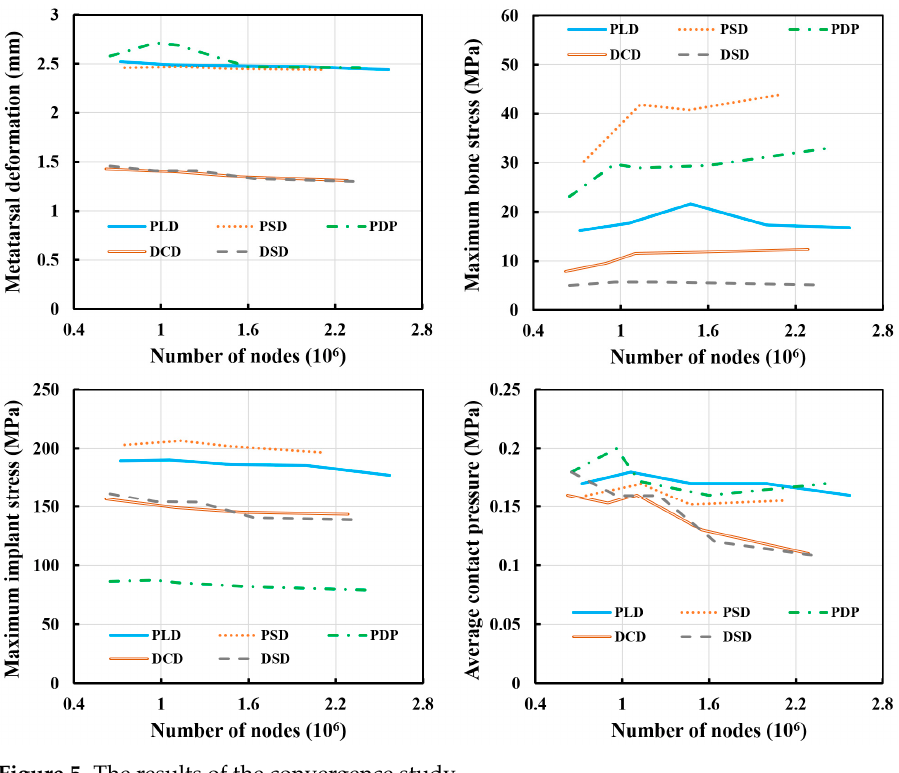
Figure 5. The results of the convergence study.